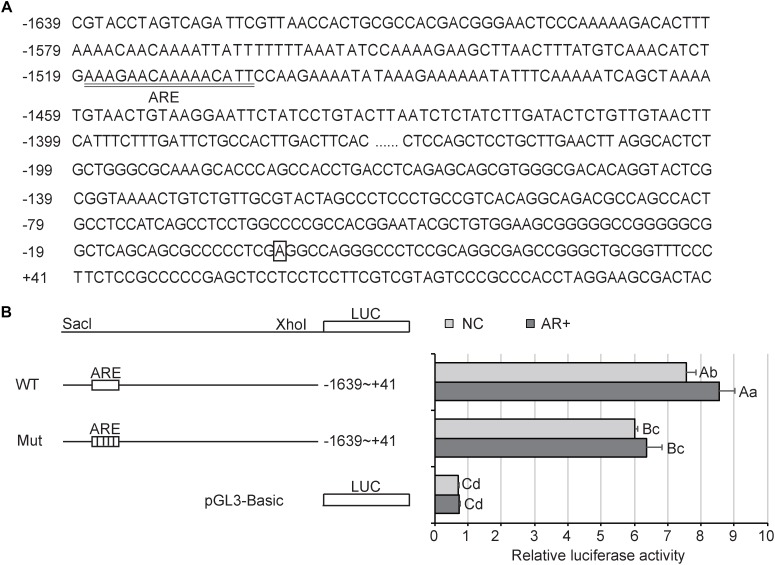
Activity analysis of AR in PK15 cells. (A) Sequence of the TFAM promoter. Nucleotide positions are indicated on the left side, with the transcriptional start site designated +1 and boxed. The putative AR elements (ARE) are underlined. (B)
TFAM reporter and luciferase assays in PK15 cells. Left: schematic representations of the luciferase construct driven by the wild-type (WT) TFAM promoter with putative AR binding sites (ARE) or mutant (Mut) reporter with mutated ARE sites. Right: luciferase activity of PK15 cells transfected with the indicated reporter. “NC” represented “negative control” that AR is not overexpressed; “AR+” presented AR is overexpressed. All data are expressed as means ± SD, 4 technical duplication in each group. Statistical comparisons were performed with Student’s t-test with Tukey’s post hoc test. The same letters indicate no significant difference (P > 0.05); the data shown with different lowercase letters indicate a significant difference (P < 0.05); the data shown with different capital letters indicate a significant difference (P < 0.01).